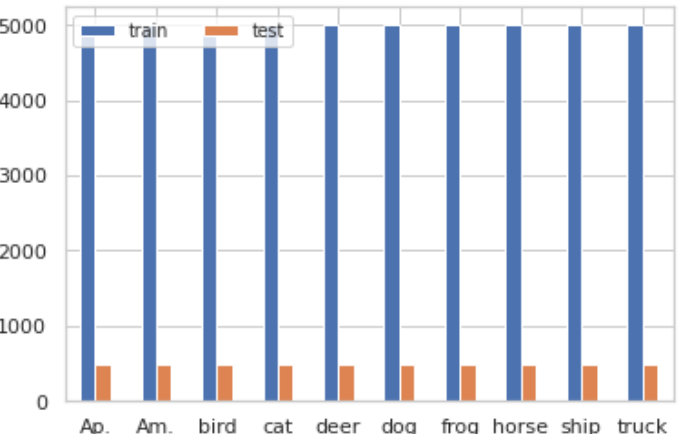
Figure A6. Training and testing labels (airplane, automobile, bird, cat, deer, dog, frog, horse, ship, truck) visualization of CIFAR-10